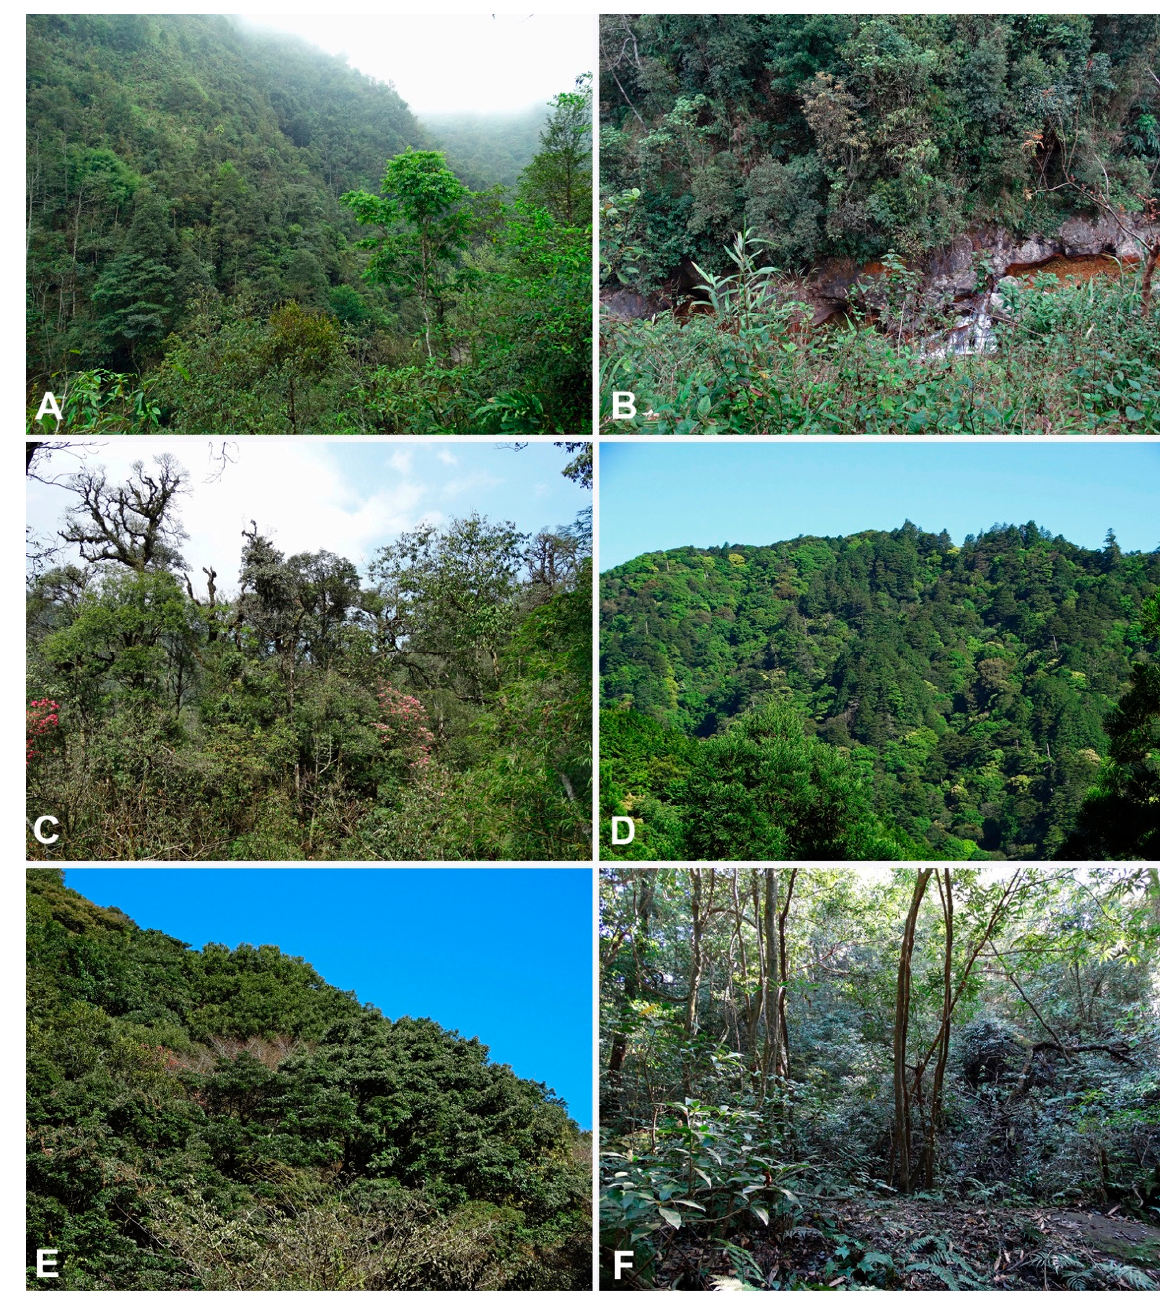
Figure 2. Representative laurosilva forest stands in Vietnam and Japan from which Phytophthora ramorum has been isolated. ( A – C ) Castanopsis - Quercus - Neolitsea dominated forests at the Fansipan in Hoàng Liên National Park, northern Vietnam. ( A , B ) Cat Cat River catchment (VN-S10) C. Catchment VN-S7. ( D ) Abies - Chamaecyparis - Tsuga - Quercus forest in catchment JP-S15, Shimanto area, Shikoku, Japan. ( E , F ) Castanopsis - Lithocarpus dominated forest in catchment JP-R22, Tarumizu area, Kyushu, Japan.